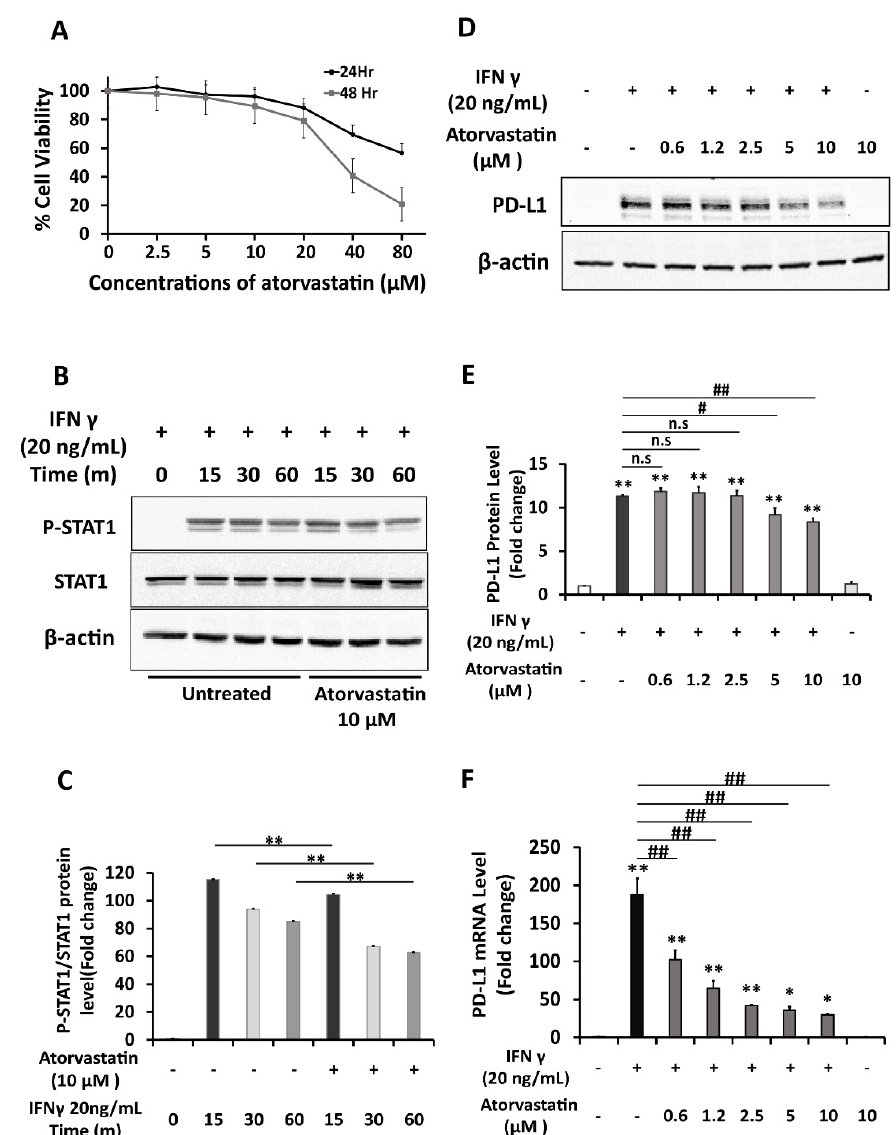
Figure 6. Induction of PDL1 expression by IFN γ is diminished by Atorvastatin, STAT-1 inhibitor, in HepG2 cells. ( A ) MTT assay for the viability of HepG2 cells treated with various concentrations